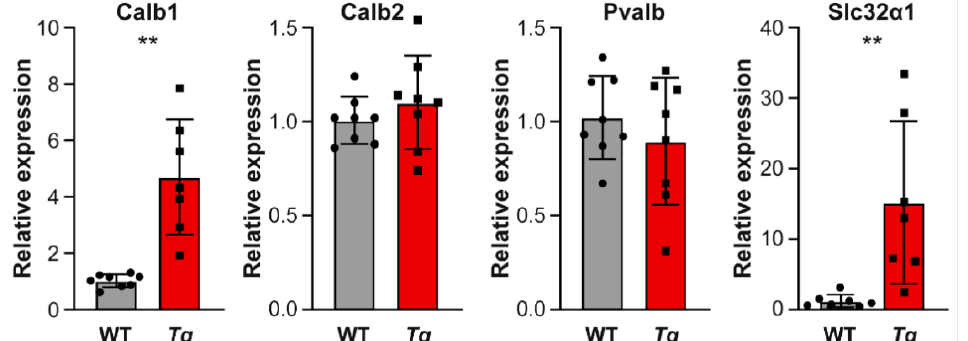
Figure 9. Calcium binding protein and inhibitory gene expression in the IC. Expression of mRNA of GABA and glycine transporter ( Slc32a1 ) and calcium binding proteins calbindin ( Calb1 ), calretinin ( Calb2 ), parvalbumin ( Pvalb ) in the WT and Tg IC. Mean ± SD, unpaired t -test, ** p <